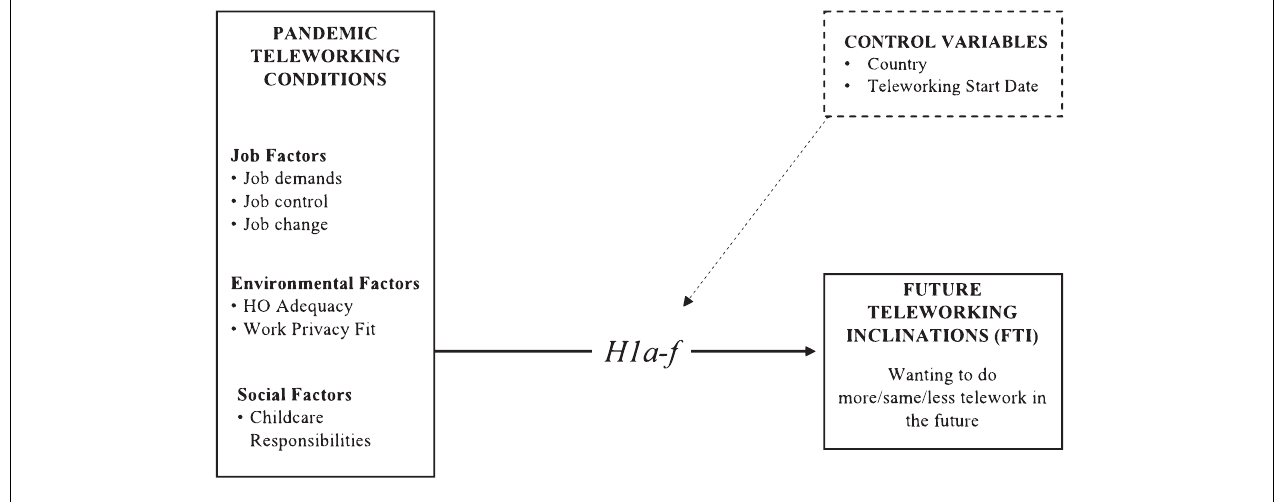
FIGURE 2 | Hypothesised relationships H.1.